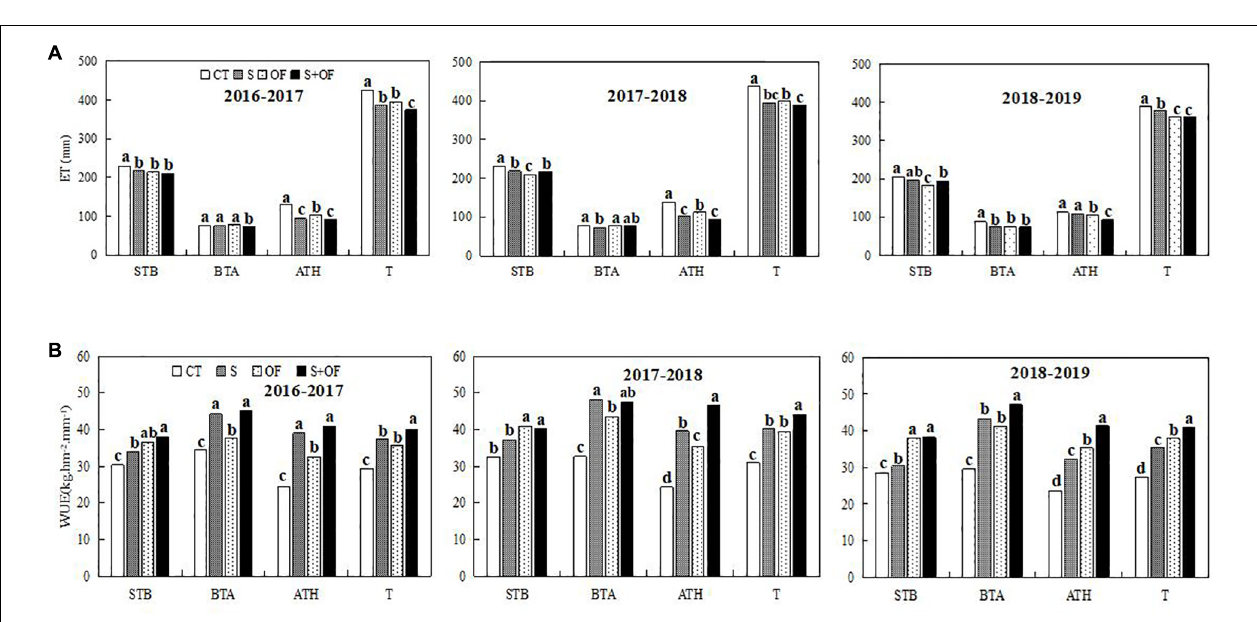
FIGURE 6 | Effects of subsoiling, organic fertilizer and subsoiling combined with organic fertilizer on soil water storage (0–100 cm) at different growth stages of wheat in the three seasons of 2016–2019. CT, conventional tillage; S, subsoiling; OF, organic fertilizer; S+OF, organic fertilizer combined with subsoiling. Different lowercase letters in the same growth stage indicate significant differences among treatments by LSD test ( P < 0.05).